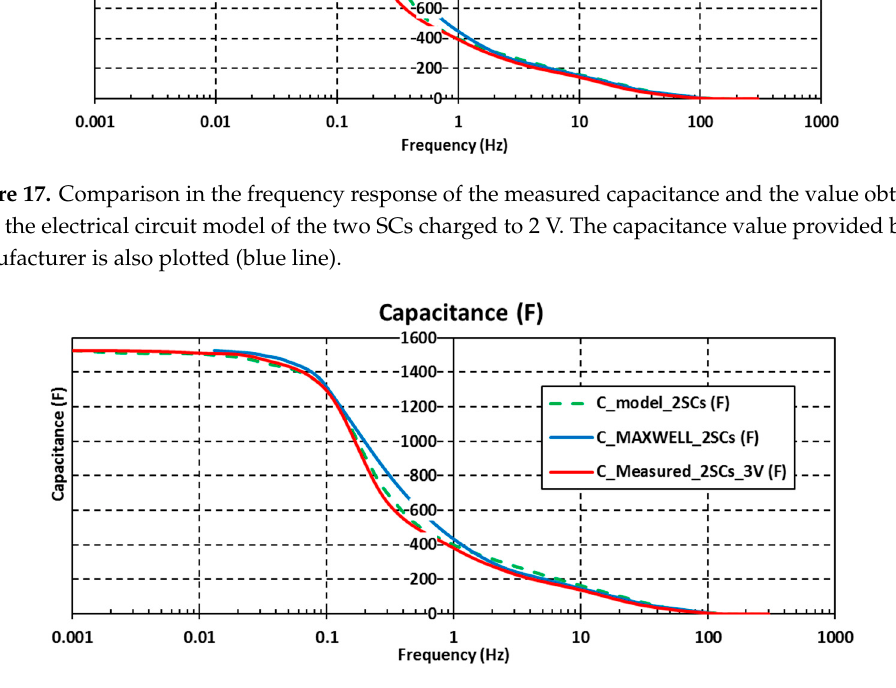
Figure 19. Comparison in the frequency response of the measured inductance and the electrical circuit model of the two SCs charged to 2.7 V.